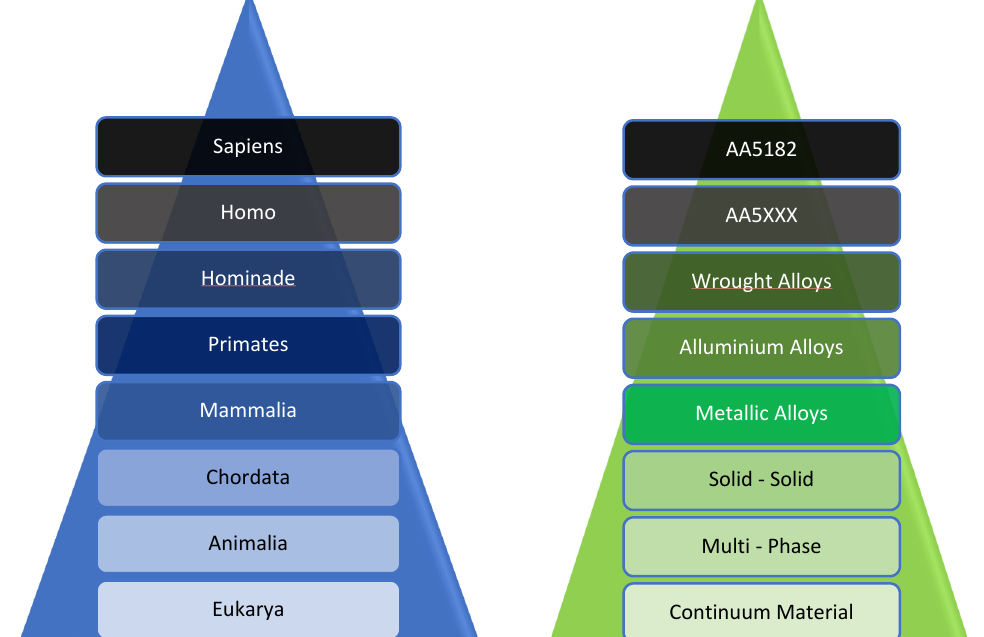
Figure 4. Left: Taxonomy of humans; Right: Taxonomy of metallic alloys. Figure 4. ( Left ) Taxonomy of humans; ( Right ) Taxonomy of metallic